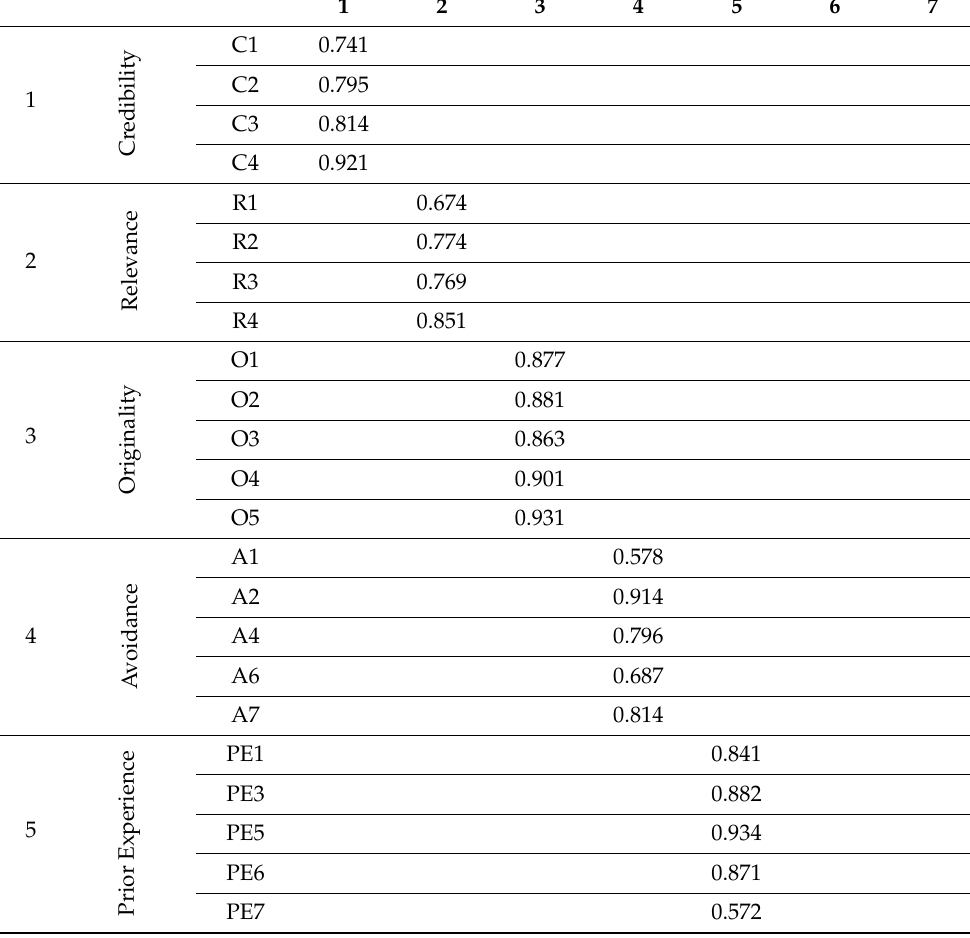
Table 2. Items Rotated Component